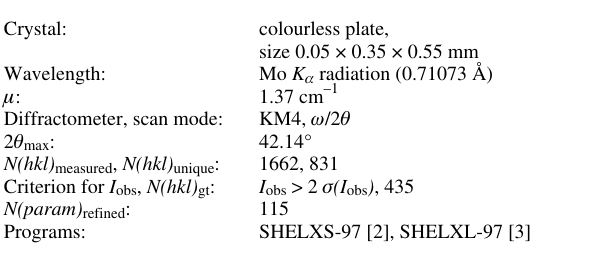
Table 1. Data collection and